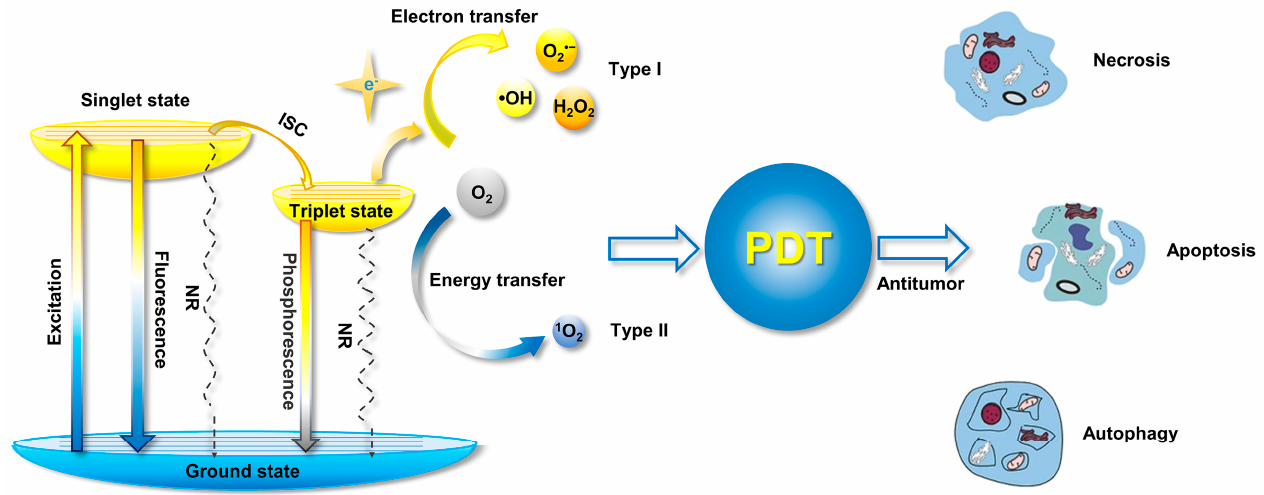
Figure 1. Examples of molecular structures of ACQ or AIE-active photosensitizers.